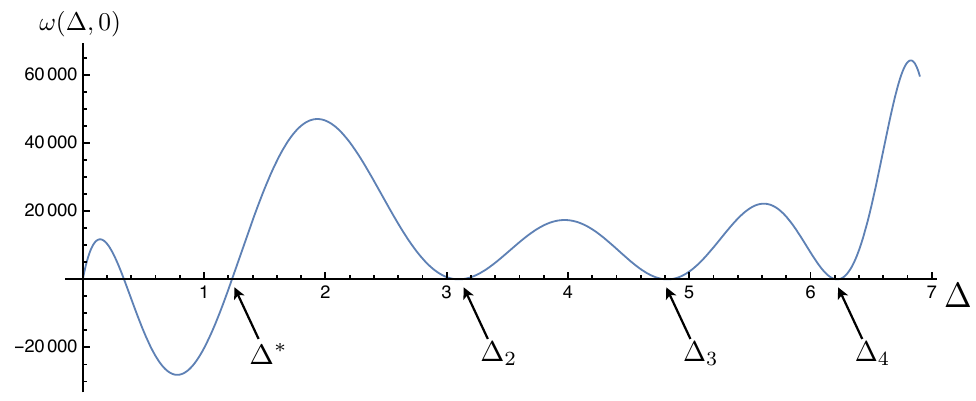
Figure 1 . The action of a typical extremal functional for the bound on the scalar gap on F The leading non-identity operator appears at a (cid:12)rst-order zero with a positive slope, while higher operators lie at second-order